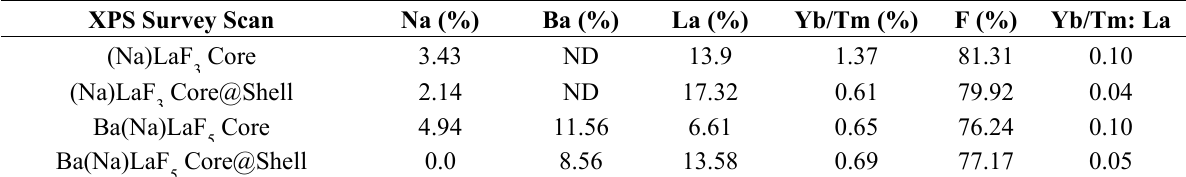
, (Na)LaF core@shell, Ba(Na)LaF 3 3